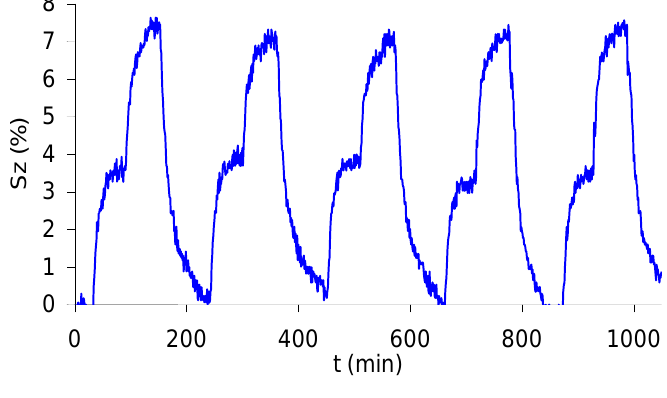
Figure 10. Eight consecutive pulses of 400+5,000 ppm, measured at 300  C and 40% RH.